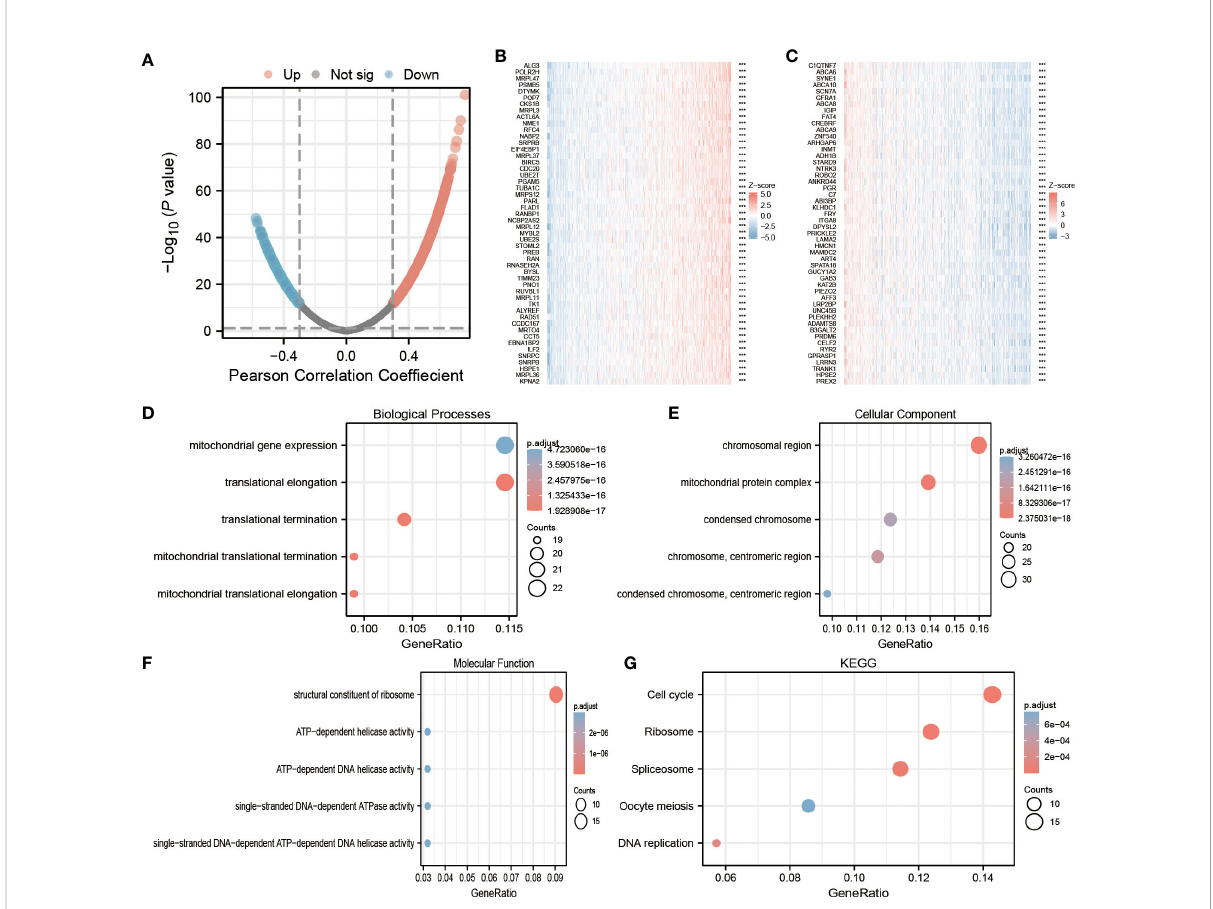
FIGURE 3 Lung adenocarcinoma (LUAD) enrichment analysis of ECE2 functional networks. (A) The volcano map showed co-expression genes associated with ECE2 expression in TCGA LUAD data sets. (B, C) Heat maps showing the top 50 co-expression genes positively and negatively correlated with ECE2 expression in the LUAD data sets. (D – F) Enrichment analysis of gene ontology (GO) terms for ECE2 co-expression genes. (G) Enrichment analysis of Kyoto Encyclopedia of Genes and Genomes (KEGG) terms for ECE2 co-expression genes. ***P <